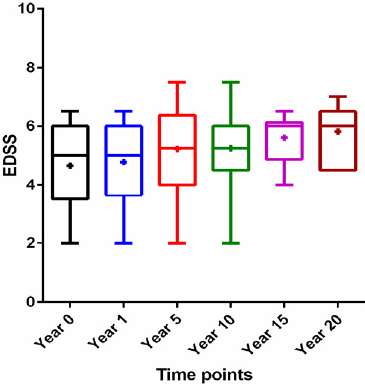
Figure 1. Expanded Disability Status Scale (EDSS) score over time: year 0 (at the cladribine induction treatment initiation), year 1 (at the end of cladribine induction treatment), year 5 (follow-up of 5 years), year 10 (follow-up of 10 years), year 15 (follow-up of 15 years), and year 20 (follow-up of 20 years). Data are presented as median (horizontal line), 25% interquartile range (box), range (whiskers), and means (middle cross).